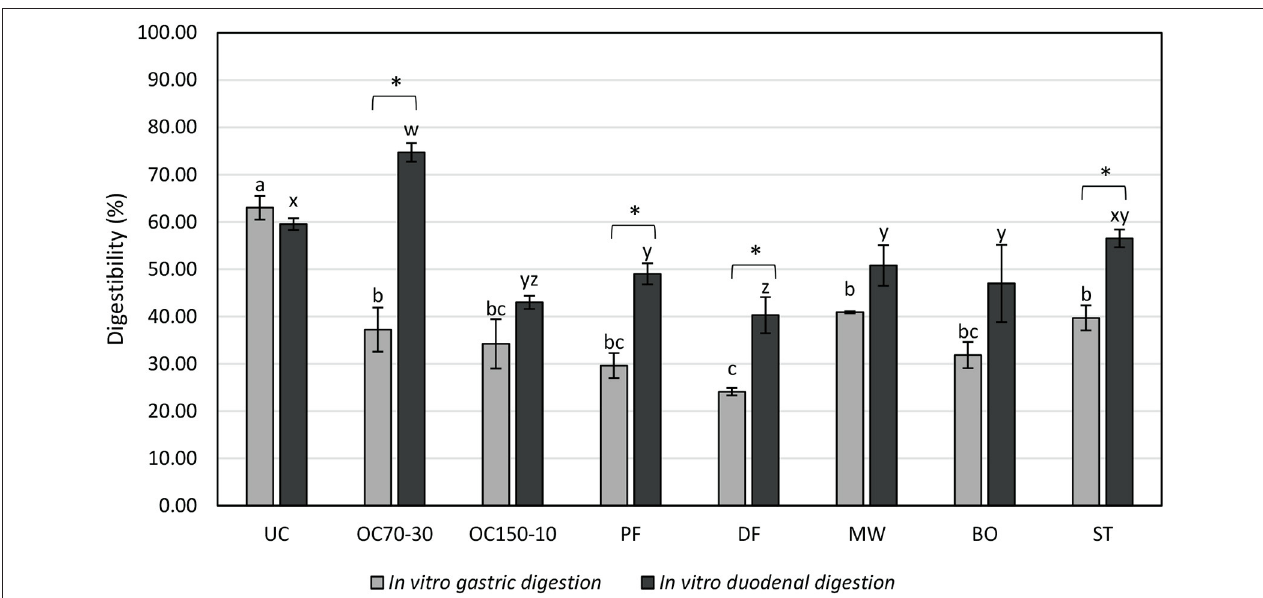
FIGURE 3 | In vitro digestibility (filtrate nitrogen content on the total sample nitrogen content, %) of uncooked larvae and larvae cooked with different techniques. UC, uncooked; OC70-30 oven cooked at 70 ◦ C for 30min; OC150-10, oven cooked at 150 ◦ C for 10min; PF, pan fried (30ml oil per 100g of larvae, 2min); DF, deep fried (300ml of oil per 100g of larvae, 2min); MW, cooked in microwave (800W per 150s); BO, boiled (plastic bag under vacuum for 30min); ST, steamed for 10min. a,b,c Letters show statistically significant differences among samples for in vitro gastric digestion at P < 0.05. w,x,y,z Letters show statistically significant differences among samples for in vitro duodenal digestion at P < 0.05. *Shows statistically significant differences between in vitro gastric and duodenal digestions among each treatment at P <